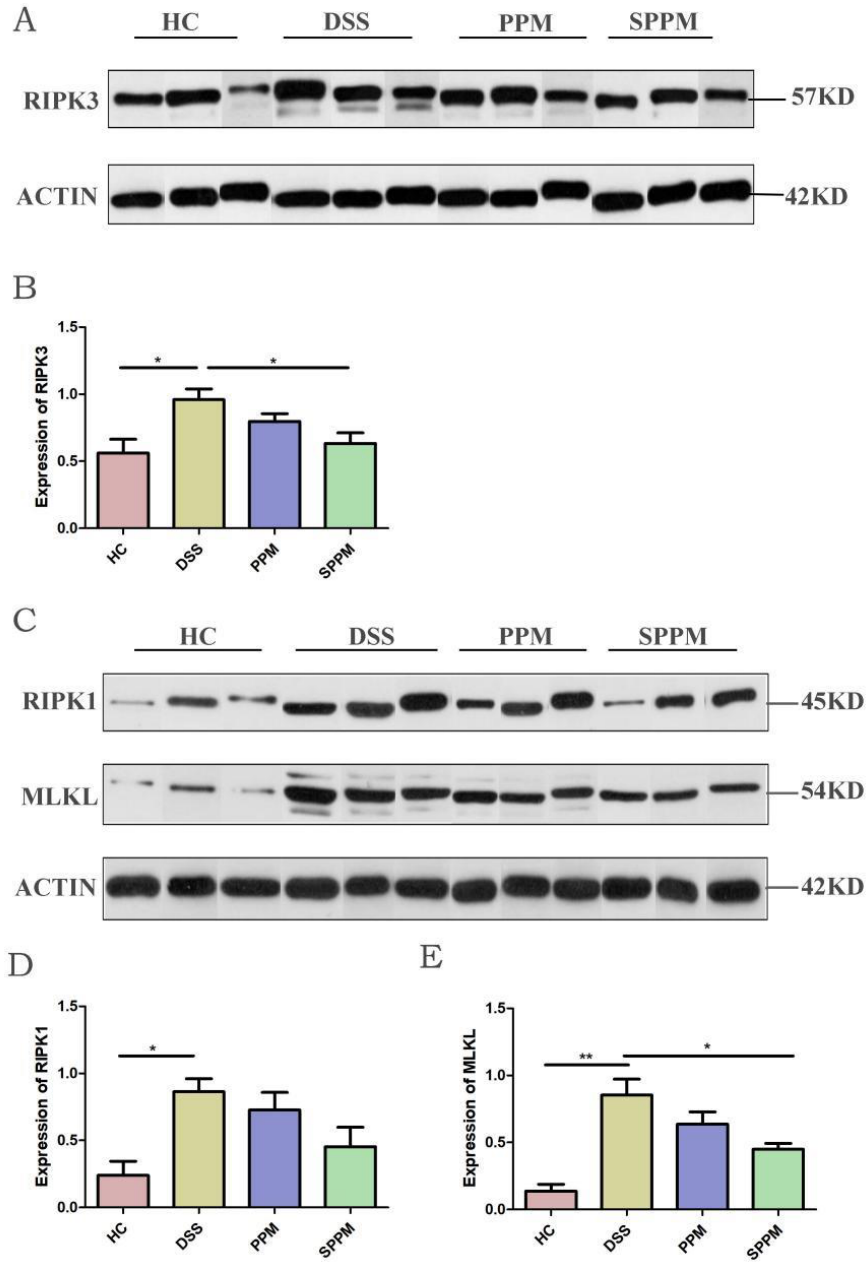
Figure 7. Expression of proteins related to necroptosis in mice by PPM60-III and SPPM60-III. ( A ) Protein expression bands of RIPK3; ( B ) quantitative analysis of RIPK3; ( C ) protein expression bands of RIPK1 and MLKL; ( D ) quantitative analysis of RIPK1; ( E ) quantitative analysis of MLKL. * p < 0.05, ** p < 0.01.